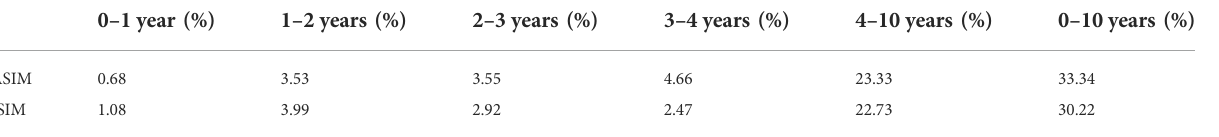
TABLE 2 Water saturation decline rate with ASIM and